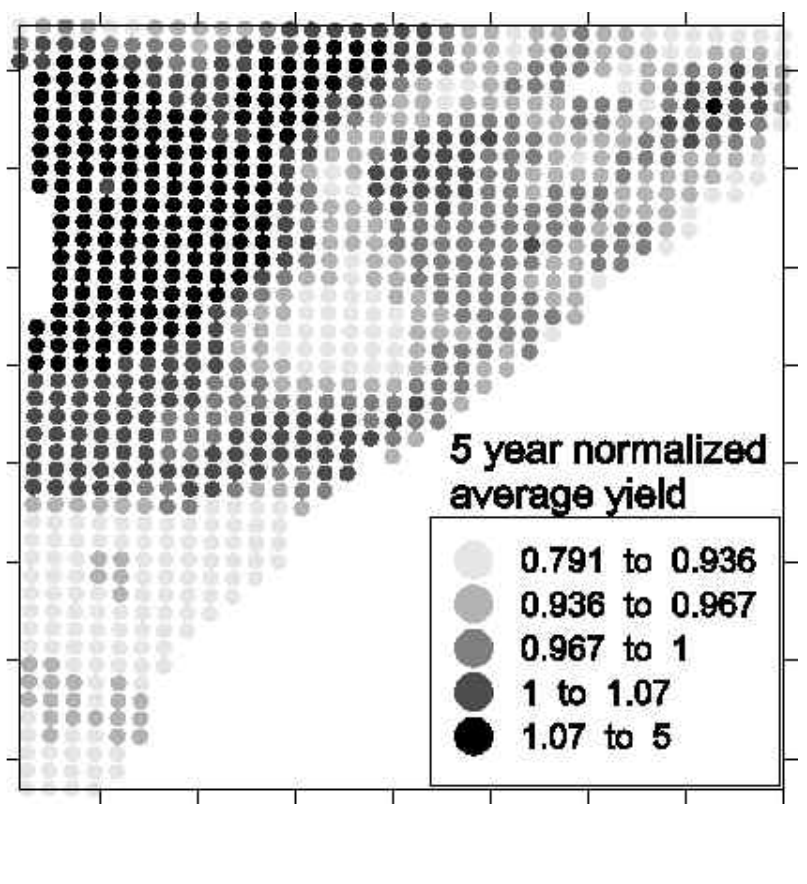
FIGURE 2. Variability of historical yield within a 10-ha